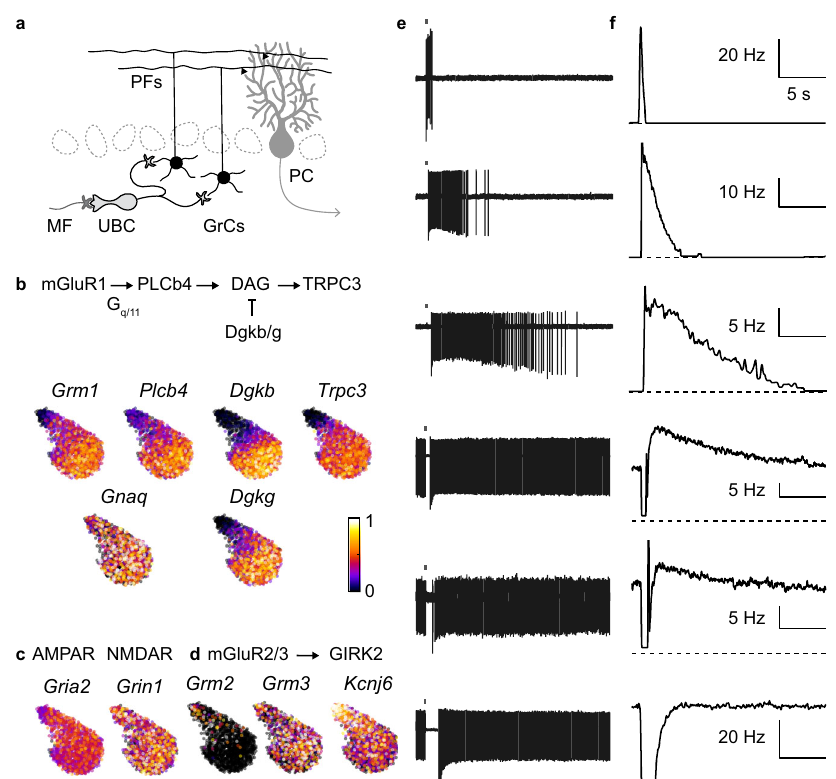
Fig. 2 Continuous variations in molecular and functional properties of UBCs. a Schematics of cerebellar circuit. b UMAP embedding showing normalized expression of gene involved in mGluR1 signaling cascade. c Same as in b for AMPA and NMDA receptors. d Same as in b for genes involved in mGluR2/ 3 signaling cascade. e Example spiking responses in different UBCs to a burst of MF input (20 stimuli at 100 Hz). f Instantaneous fi ring rate for the same